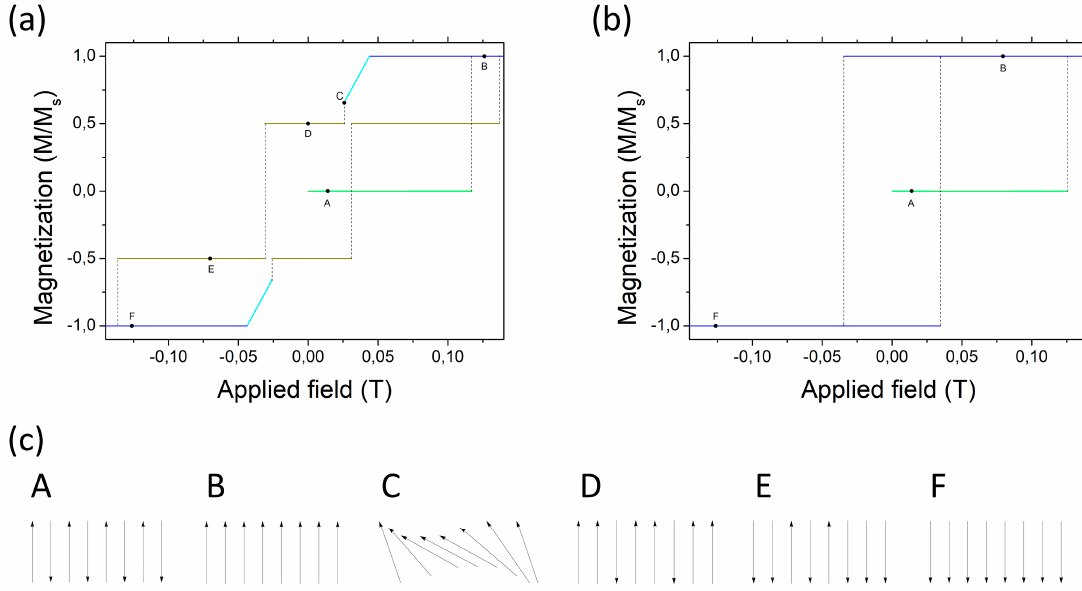
Figure 9. Magnetization sequence under the applied magnetic field in a S-W model of ( a ) eight stripes, ( b ) eight ellipsoids. The starting configuration for H = 0 is antiferromagnetic. Panel ( c ) represents the stages of magnetization switching in the case of the stripes marked with the letters A, B, C, D, E and F.